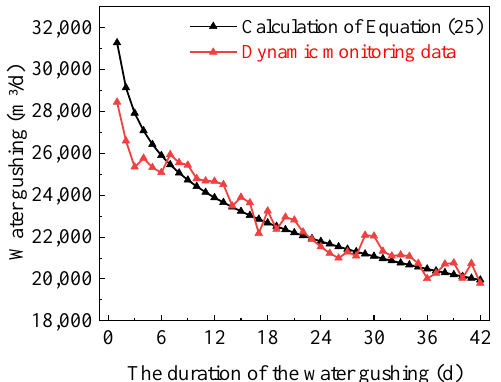
Figure 12. Results of comparison of calculated values with dynamic monitoring data from K91+700 to K91+950.